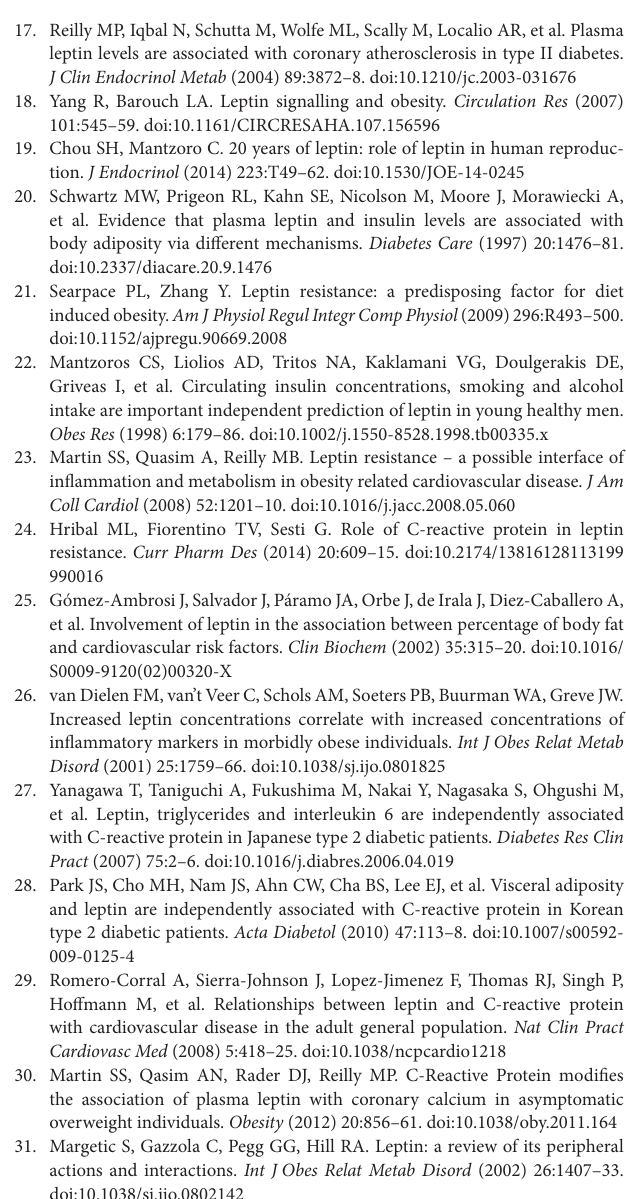
FigUre s1 | Immunoblot analysis of co-precipitated soluble leptin receptor (sOb) R C-reactive protein (CRP) was immunoprecipitated from human serum, subjected to 7.5% SDS-PAGE, followed by Western blotting, probed with anti-sOb R, and located by ECL (B) Negative controls: anti-CRP immunoprecipitate probed without anti-sOb R (only HRP conjugated secondary antibody) served as negative control (c) for identification of co-precipitated sOb R (B) . Anti-sOb R immunoprecipitate, probed without anti-CRP (only HRP conjugated secondary antibody) served as negative control (a) for identification of co-precipitated CRP (Figure